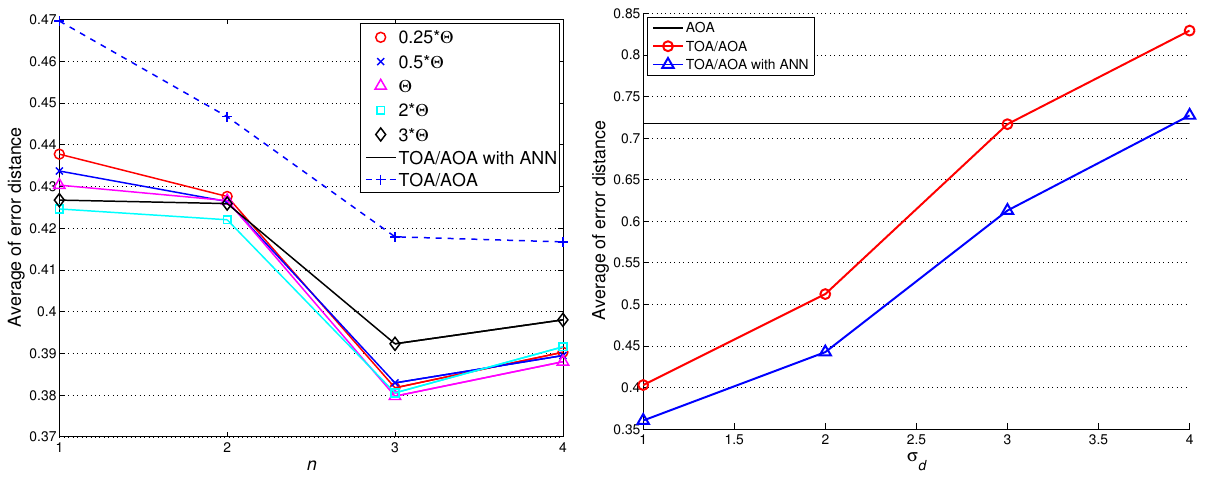
Figure 14. The comparison of target localization error with/without ANN refinement ( left ); the performance comparison of TCAT with joint AOA/TOA and TCAT with AOA only with varying the deviation of TOA measurement ( right